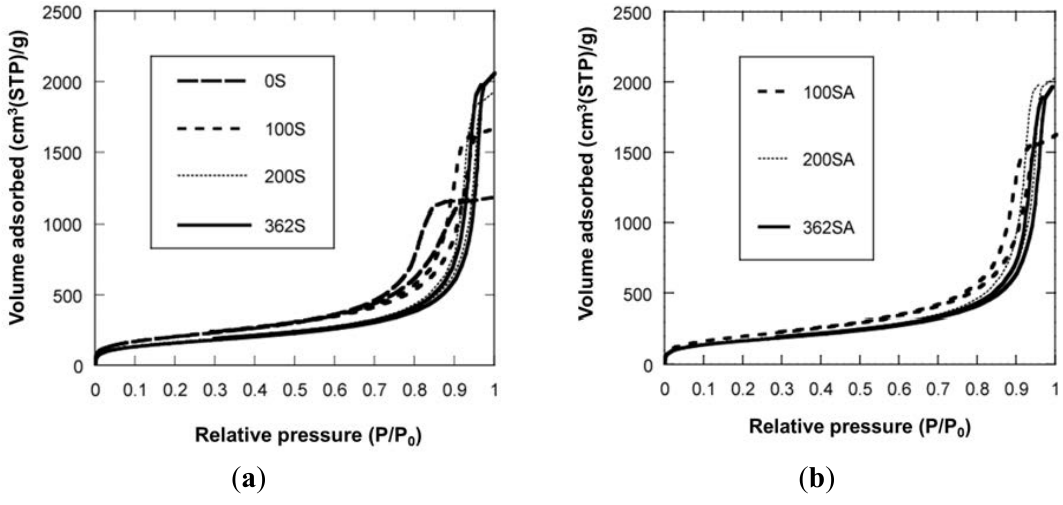
Figure 3. N adsorption-desorption isotherm. ( a ) Silica; ( b ) Silica-alumina. 2